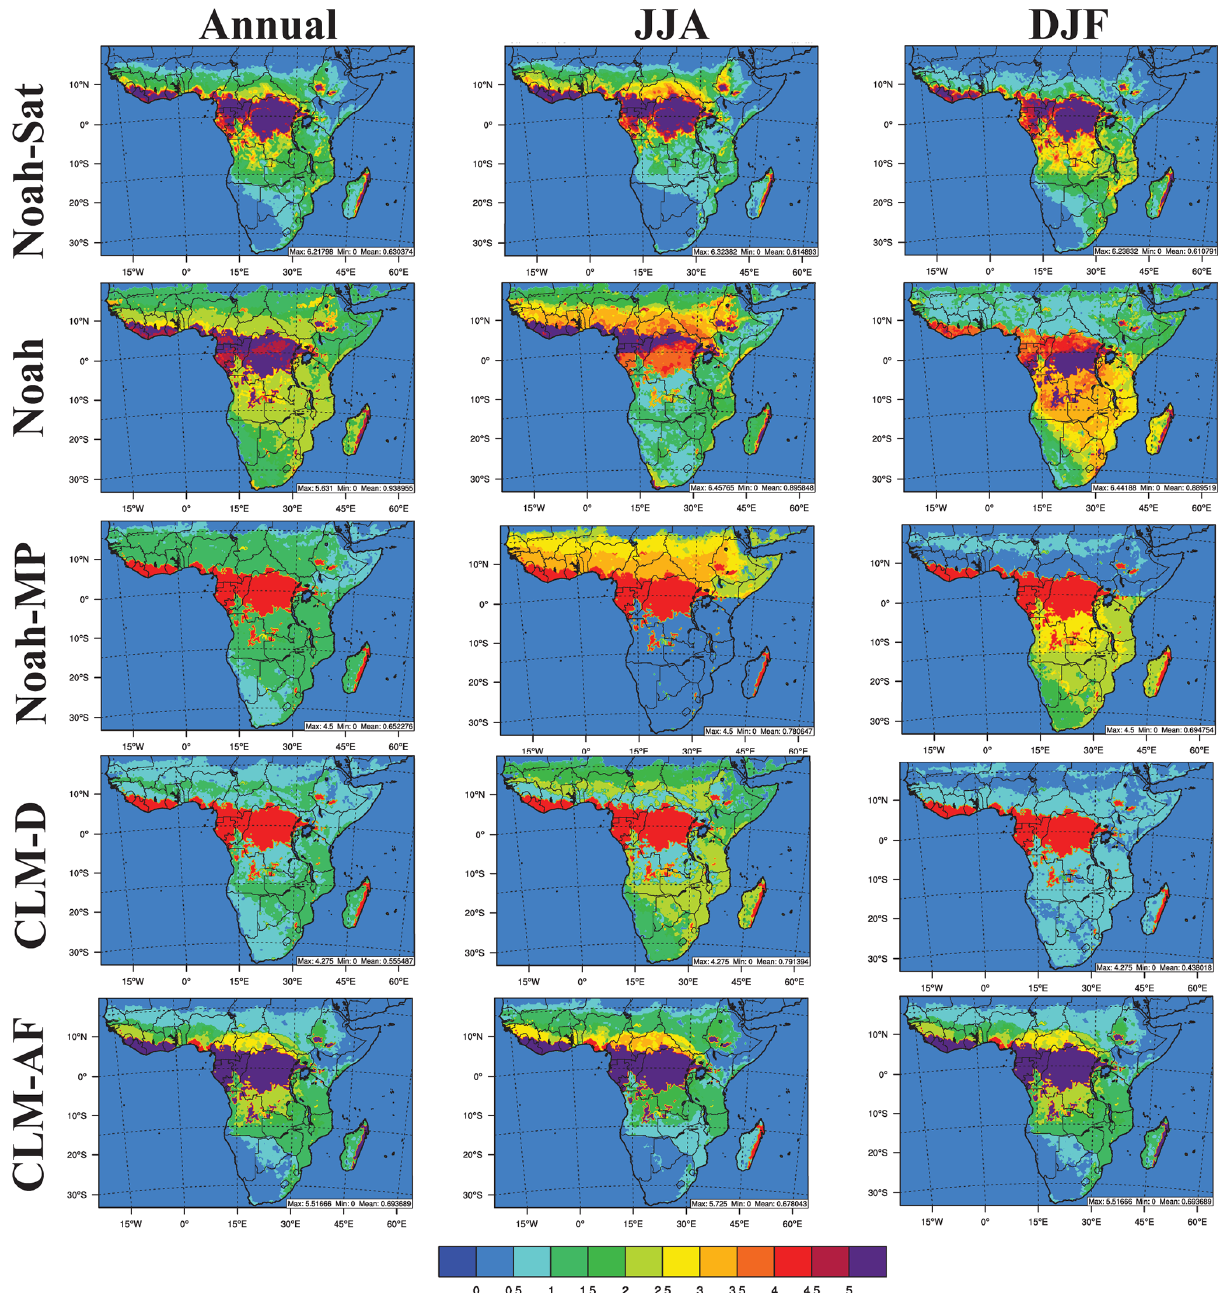
Figure 3. Comparison of annual, summer (JJA), and winter (DJF) average LAI (m 2 m − 2 ) between LSM configurations. Since Noah-Sat is based on satellite observations, it can be treated as